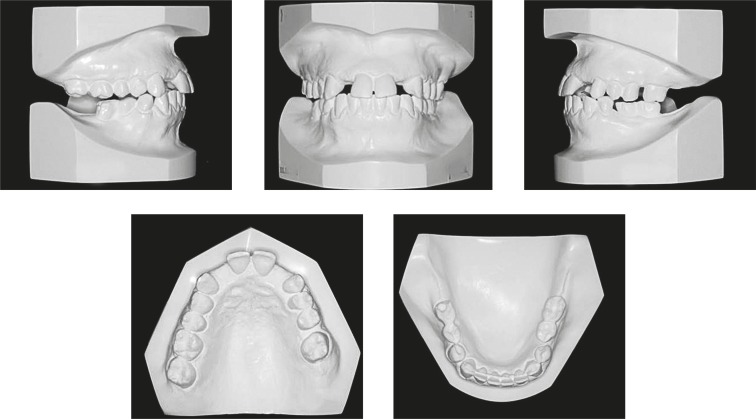
Final dental casts.